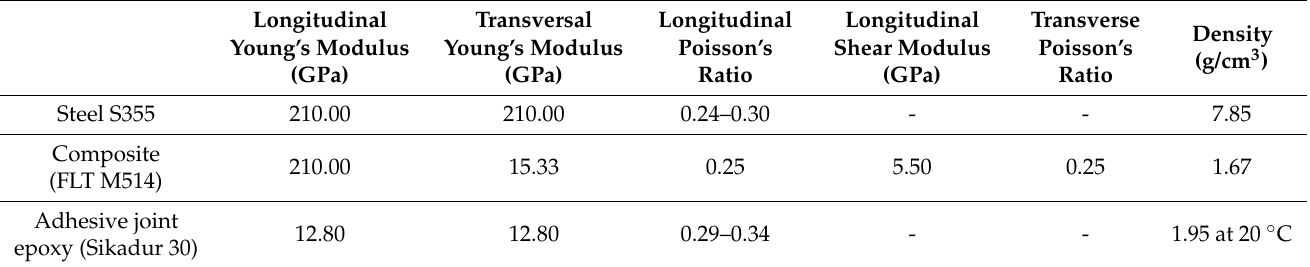
Figure 1. Schematic representation of the composite/metal assemblies: ( a ) α -type sample; ( b ) sample with β 2-type defect (1/3 void); ( c ) sample with β 1-type defect (centered void). Table 1. Composite, steel and epoxy properties.